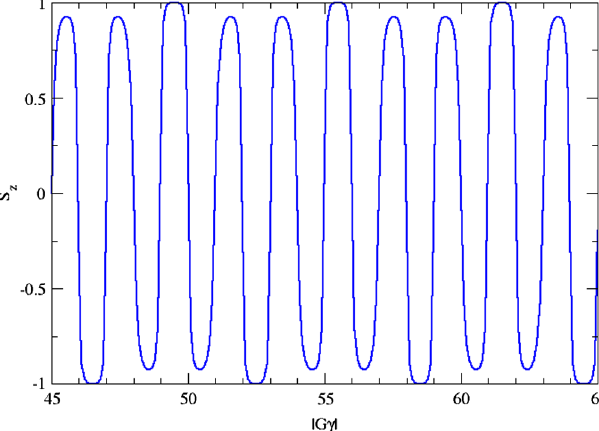
longitudinal axis by angles δ